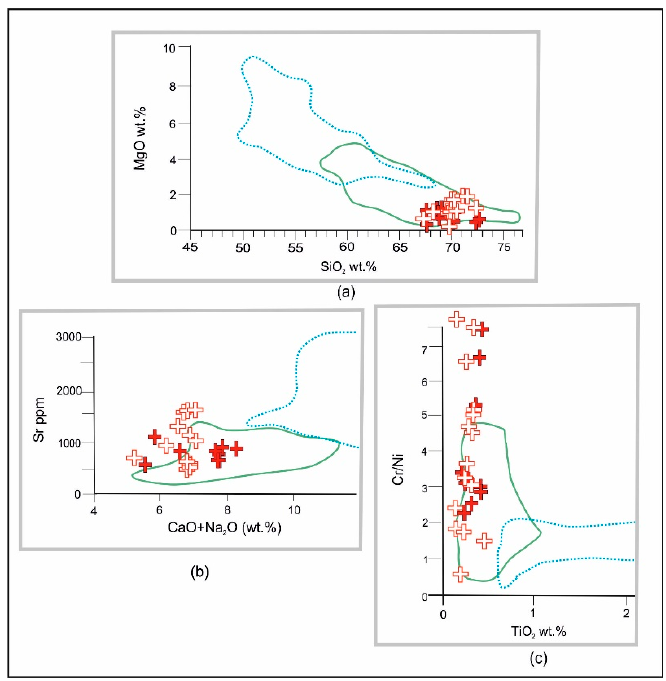
Figure 7. The location granitoids of the adakite series of the EF MOOB framing on the correlation diagrams [46]: ( a ) MgO − SiO 2 ; ( b ) Sr − CaO + Na 2 O); ( c ) Cr/Ni − TiO 2 . Solid line—high siliceous adakites; dotted line—low-silica adakites. See the legend in Figure 2.